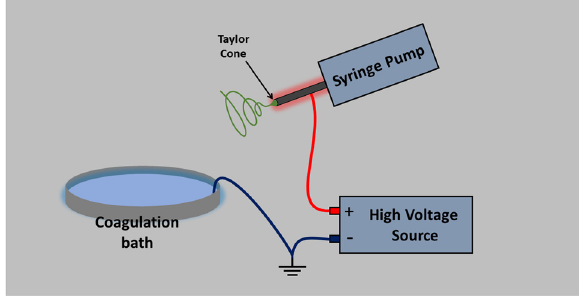
Figure 6: Schematic representation of electrospinning from IL